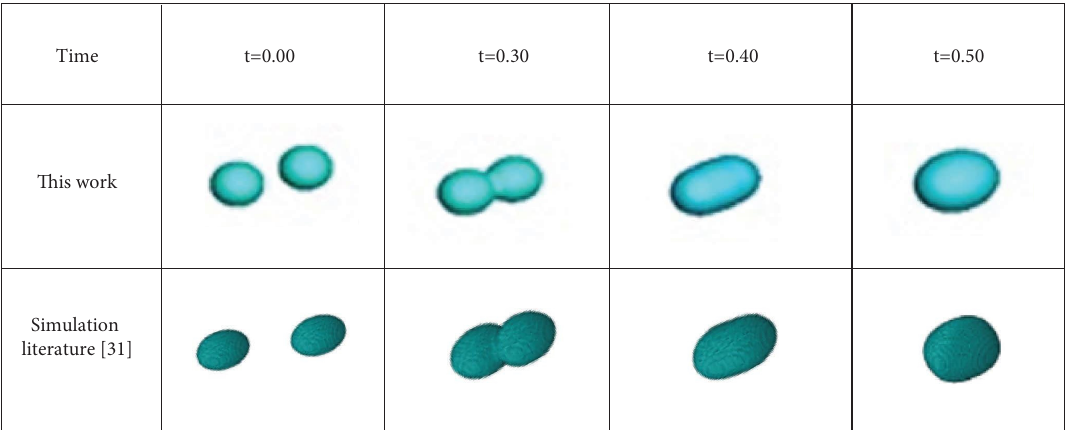
Figure 3: Verifcation of simulation results based on literature [31] at We � 75 and no droplet evaporation.